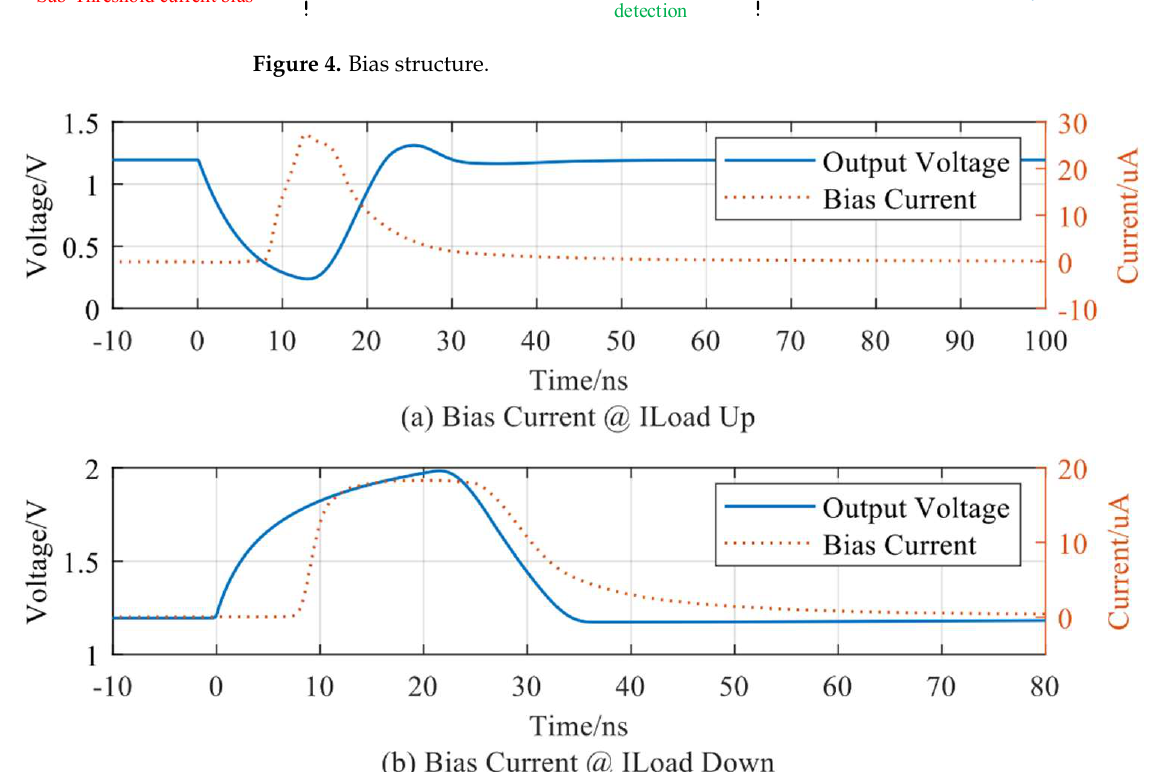
Figure 5. Transient bias response.